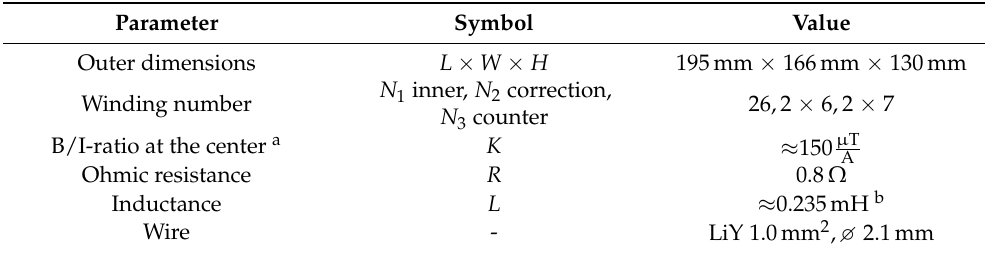
Table 1. Technical parameters of the coil. a The B/I ratio was calibrated by measuring the coil current with a calibrated multimeter (Supplement, calibration certificate ‘Keithley DAQ6510’) versus the magnetic-field intensity (Supplement, Figure S3) with calibrated Fluxgate magnetometer (Supplement, calibration certificate for ’FLUXMASTER’). b The inductance was measured by the frequency response in a LCR-resonant test circuit with a known